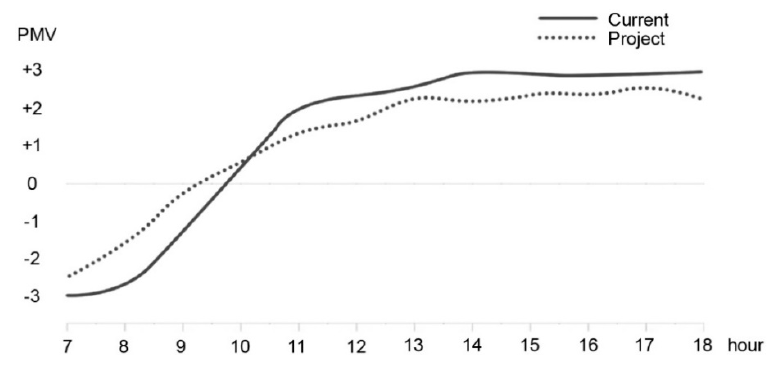
Figure 11. PMV trend—Hottest day.